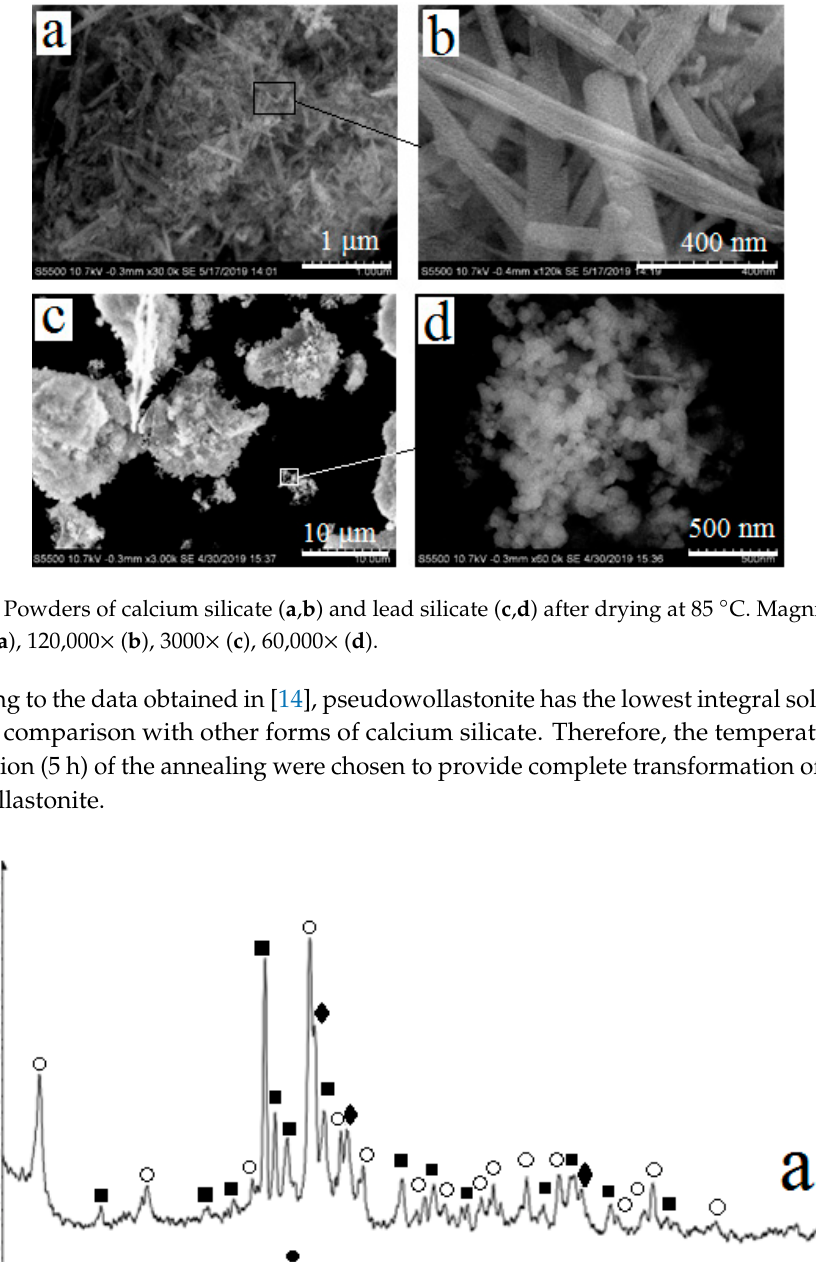
-tobermorite (cid:35)